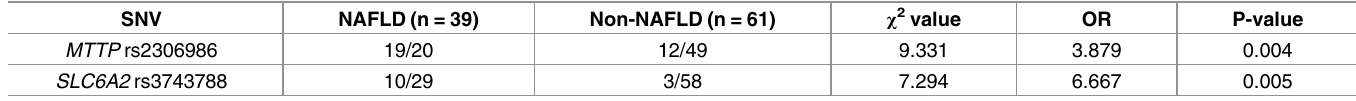
The variants that were not on target were excluded, resulting in 494 variants within the 36 target genes per subject (S1 Table). After completion of analysis steps by the functional filter described in Methods, 97 nonsynonymous exonic variants per patient were verified (S2 Table). All the mutations were scored as ’damaging’ by at least 1 of the 4 algorithms (SIFT23, PolyPhen-2, Mutation Taster and GERP++). Mutation rates in the NAFLD subjects, non-NAFLD subjects and the in-house controls were compared, using Fisher’s Exact Test (S3 Table). Twenty-six SNVs were found to be enriched in the subjects with NAFLD when compared with in-house controls (all P < 0.05) (S3 Table). The 26 SNPs were located in 16 genes; MTTP rs2306986 and SLC6A2 rs3743788 were significantly higher in subjects with NAFLD compared to non-NAFLD (OR: 3.879; P = 0.004; OR: 6.667, P = 0.005, respectively), see Table 2. Table 2. Comparison of mutation rate in MTTP rs2306986and SLC6A2 rs3743788 between NAFLD group and non-NAFLD group (of Chinese Han ethnicity). SNV NAFLD (n = 39) Non-NAFLD (n = 61) χ 2 value OR